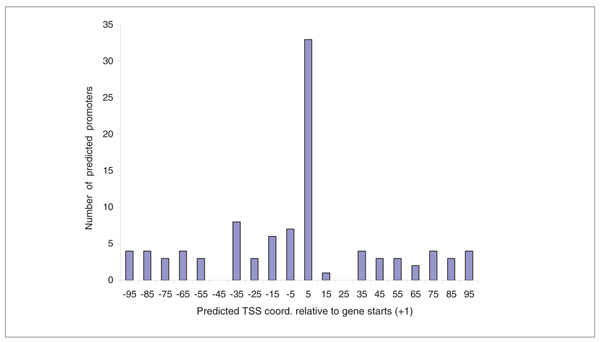
A distribution of predicted TSS near the start of mRNA sequences. Figures on the x-axis are centers of 10 bp intervals, for example, mark 5 corresponds to [+1,+10] interval.